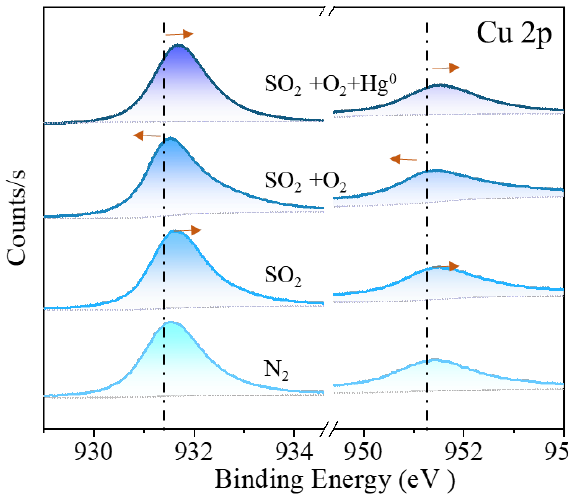
Figure 10. Cu 2p of spent c-CuS samples under pure N 2 , 6% vol SO 2 , 6% vol SO 2 + 6% vol O 2 , and 6% vol SO 2 + 6% vol O 2 +Hg 0